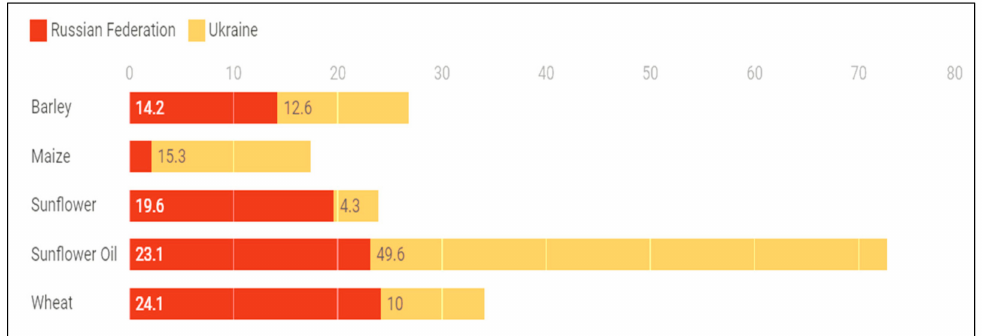
Figure 2. Shares of Russia and Ukraine in the global trade of selected commodities (2018–2020). Source: Glauber and Laborde